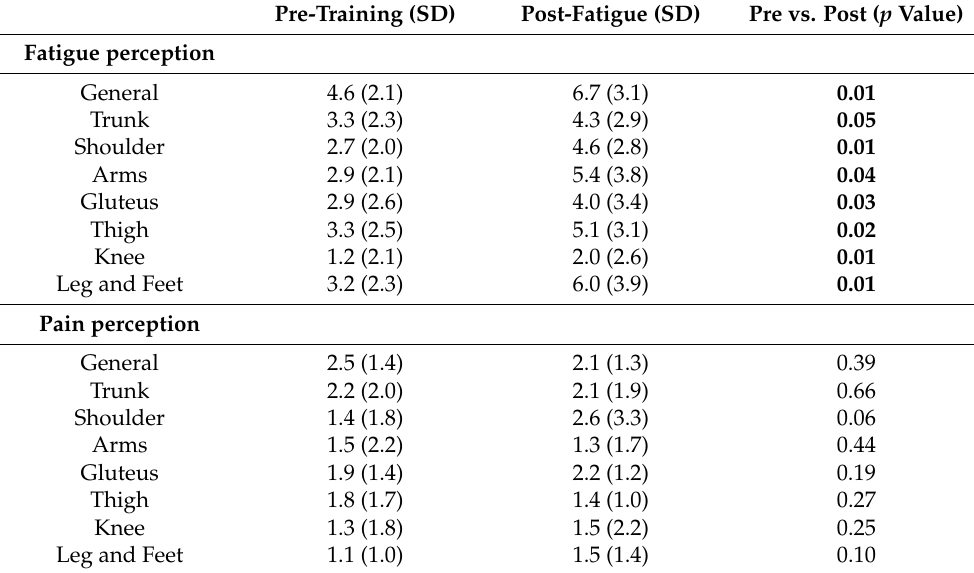
Table 1. Pre- and post-training fatigue and pain data. Mean (SD). 0 (no pain/fatigue); 15 (very painful/fatigued).